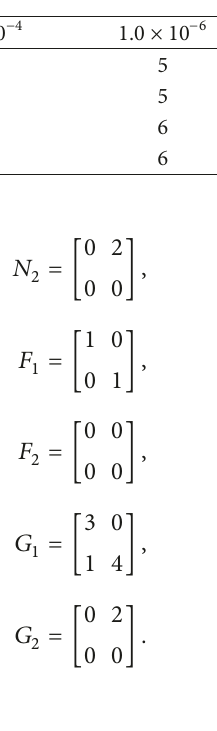
Table 4: Between the iteration allowable error and the number of iterations.